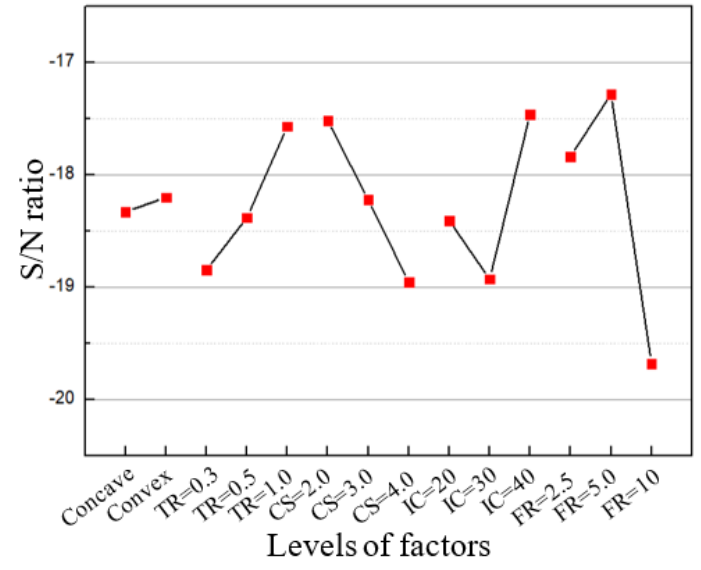
Figure 13. S/N ratio of levels for each